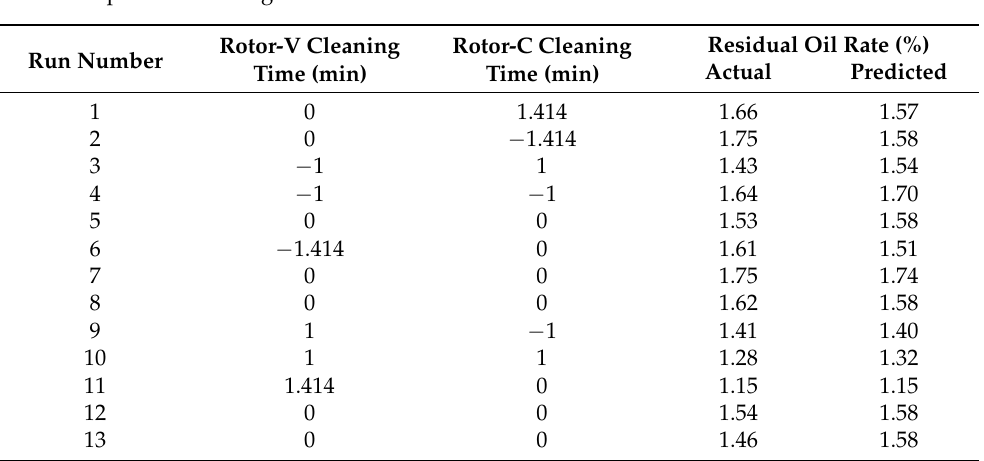
Table 3. Experimental design and